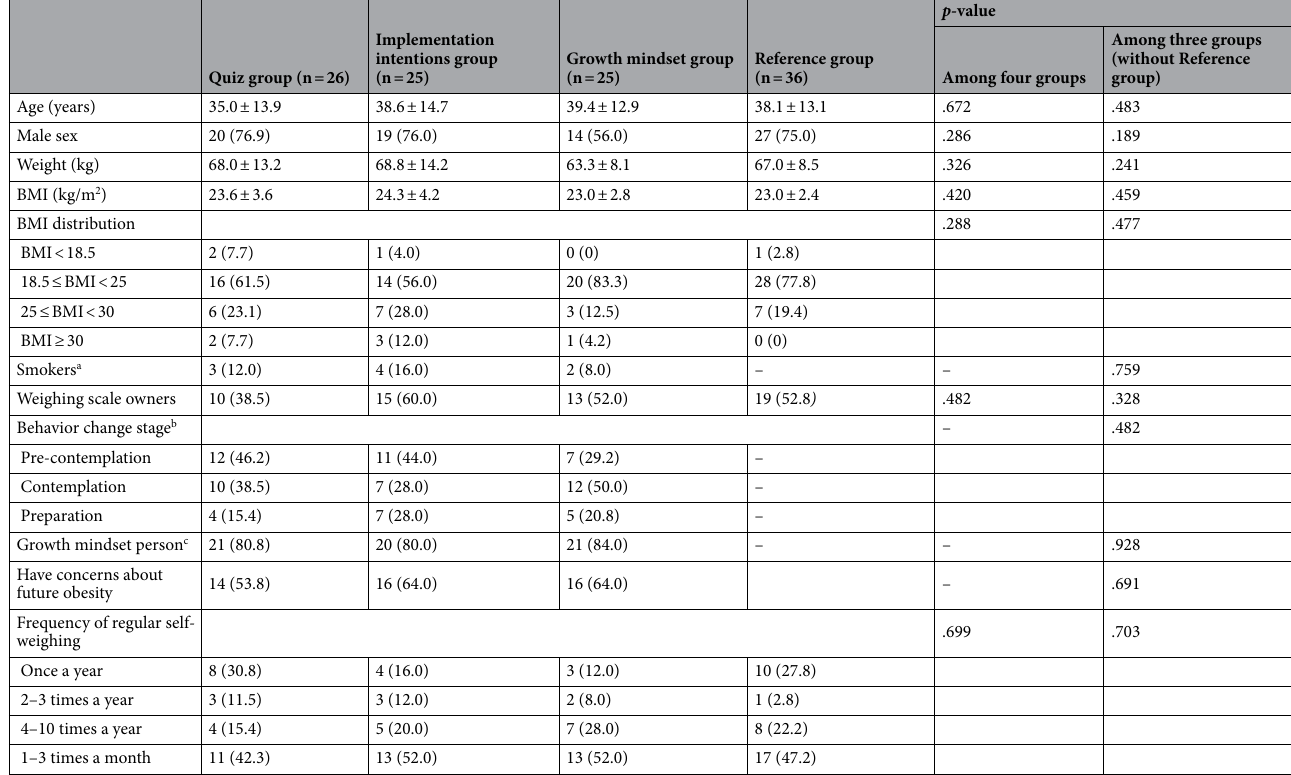
Table 1. Baseline characteristics of participants [mean ± SD, n (%)]. Missing values were excluded from the analysis. Analysis of variance was used for age, weight, and BMI, and the Kruskal–Wallis test was used for the categorical data of appropriate weight distribution, stage of behavioral change, and frequency of regular weight measurement, while χ 2 test or Fisher’s exact test (items less than five) was used for the other